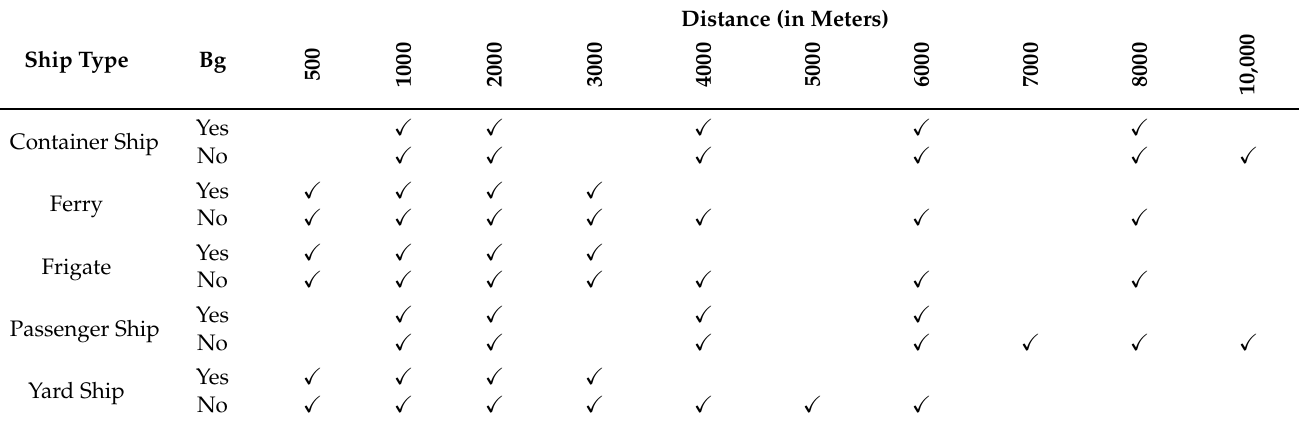
Table 1. We consider five classes of objects (Ship Type), the presence or the absence of background (Bg), and different distances of the object to the camera while generating synthetic